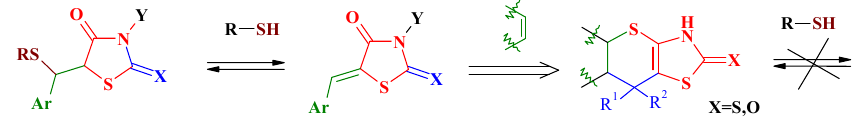
Figure 1. Background for thiopyrano[2,3- d ]thiazoles design.